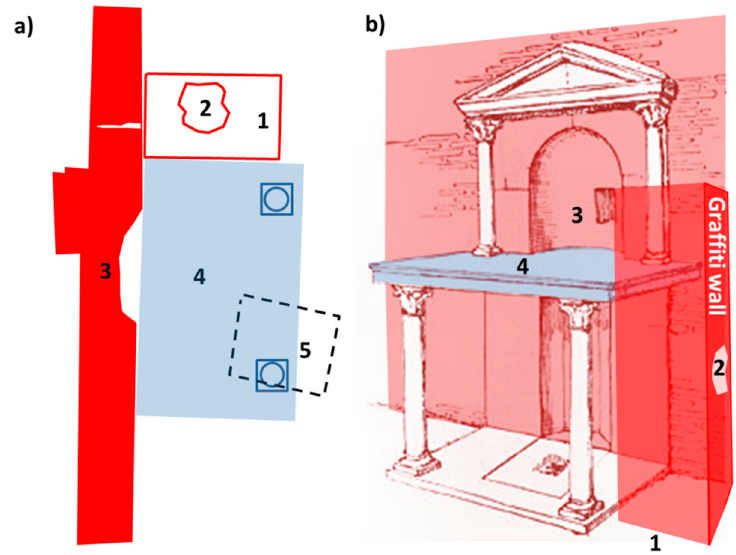
Figure 2. ( a ) Plan of the Peter’s Tomb in the Vatican: 1. Prop “wall g”; 2. Cavity inside the “wall g”; 3. Red wall; 4. II century aedicula (Trophy of Gaius); 5. A sepulcher under the floor. ( b ) Vertical sketch of the Trophy of Gaius (Figure published on BAS Library (Biblical Archaeology Society Online Archive): Finegan, J. The Death and Burial of St. Peter, Biblical Archaeology Review 2, 1976, www.basilibrary.org / biblical-archeology / 2 / 4 / 2, last access 2 September 2020), with highlighted colors to better show correspondences with panel ( a